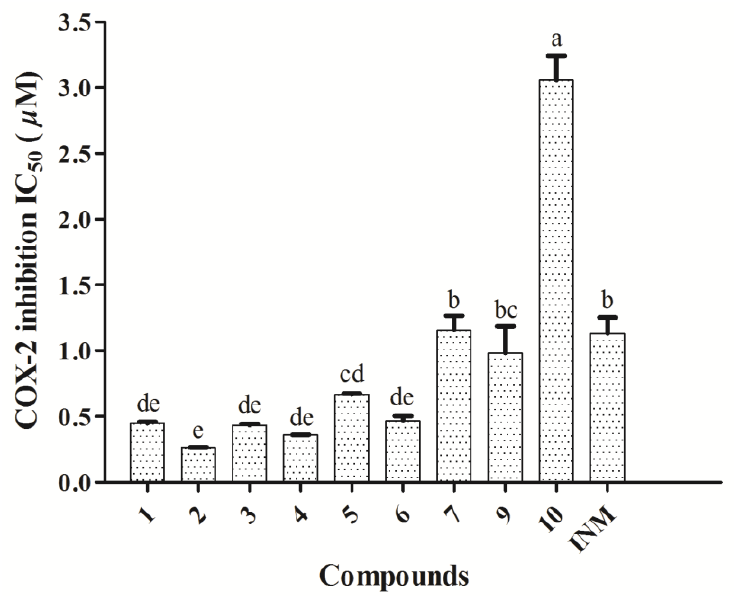
Figure 6. IC 50 values of compounds 1 − 7 and 9 − 10 in the COX-2 activity inhibition assay. INM was used as the positive control. Compound 8 did not show any activities in this assay. Data are expressed as means ± SD ( n = 3). Means labeled by different letters (a–e) were significantly different at a level of p < 0.05 ( n = 3) by one-way ANOVA DMRT.